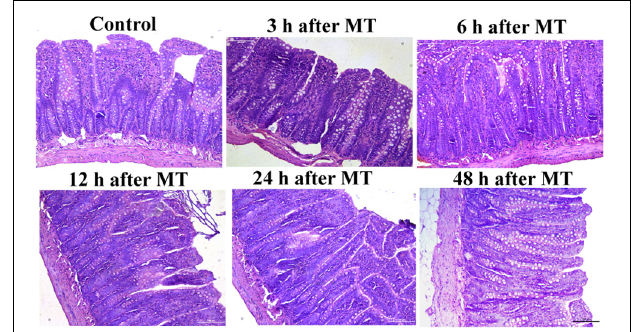
FIGURE 2 | Changes in the ileum mucosa of the SD rats at different times after MT (200 × ). The morphology of ileum mucosa in all groups of different time points after MT were similar to that in the control